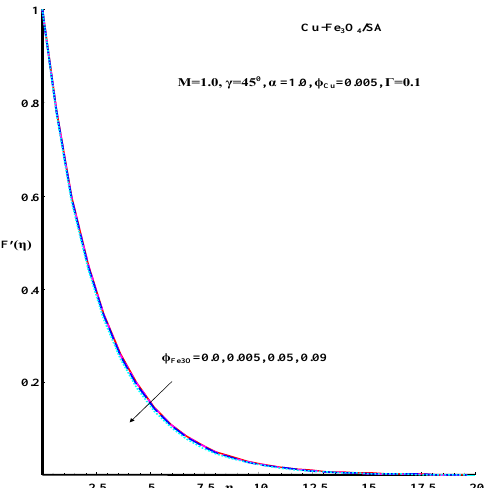
Figure 3. Effect of velocity variation of Cu / SA hybrid nanofluid.